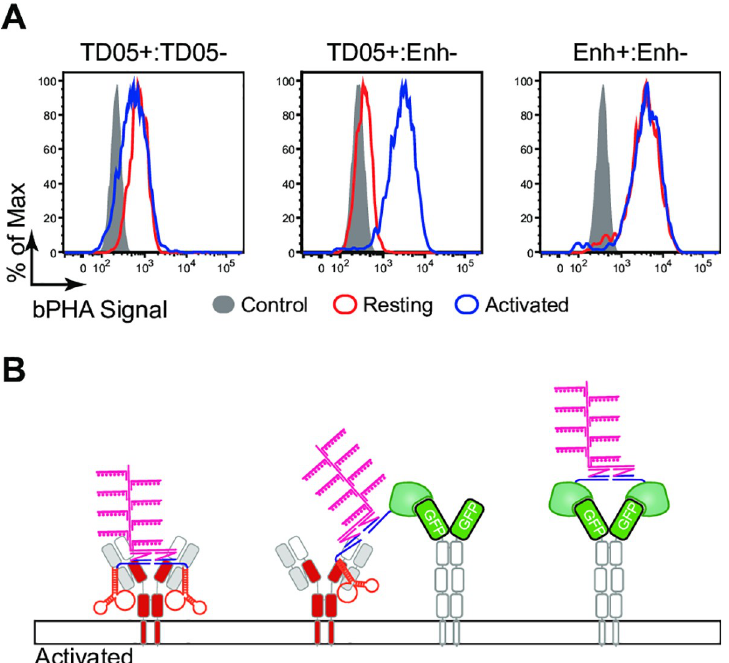
Fig 4. The bPHA confirms the rearrangement of BCR upon stimulation. (A) TD05+:TD05 − , TD05+:Enh − , and Enh+:Enh − bPHA signals were measured by flow cytometry for resting and stimulated IgM-KO GFP- μ m-expressing Ramos cells. The stimulated cells without the corresponding target binding probes served as control. Data represent four independent experiments. (B) Schematic diagrams showing that on the surface of IgM-KO GFP- μ m-expressing Ramos cells surface, upon stimulation, IgD-BCR and GFP- μ m mix together, producing positive TD05+:Enh − bPHA signal. BCR, B cell antigen receptor; bPHA, branched proximity hybridization assay; Enh, Enhancer;